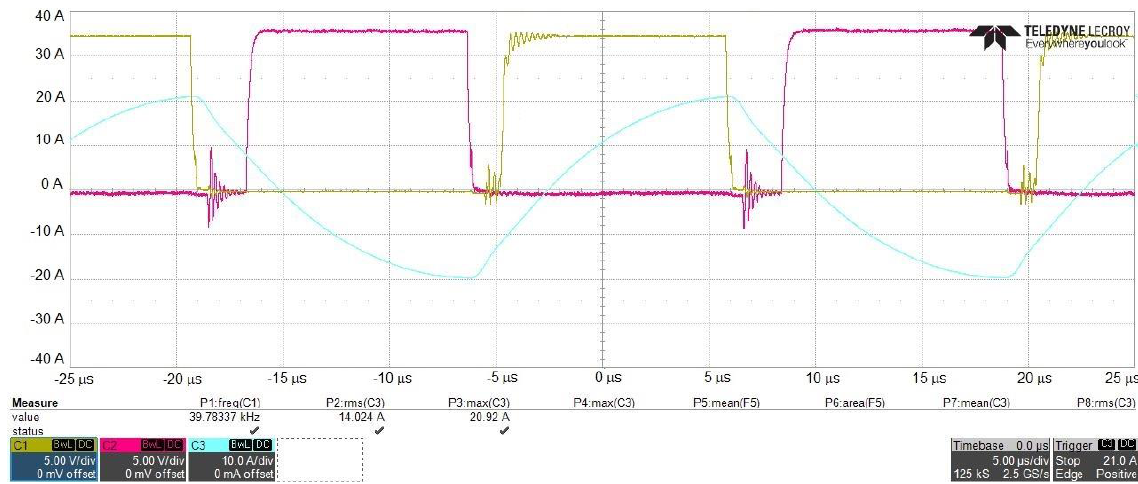
Figure 33. High-side IGBT control signal (C1, green), low-side IGBT control signal (C2, purple), and transmitter coil current (C3, blue) at 39 kHz.